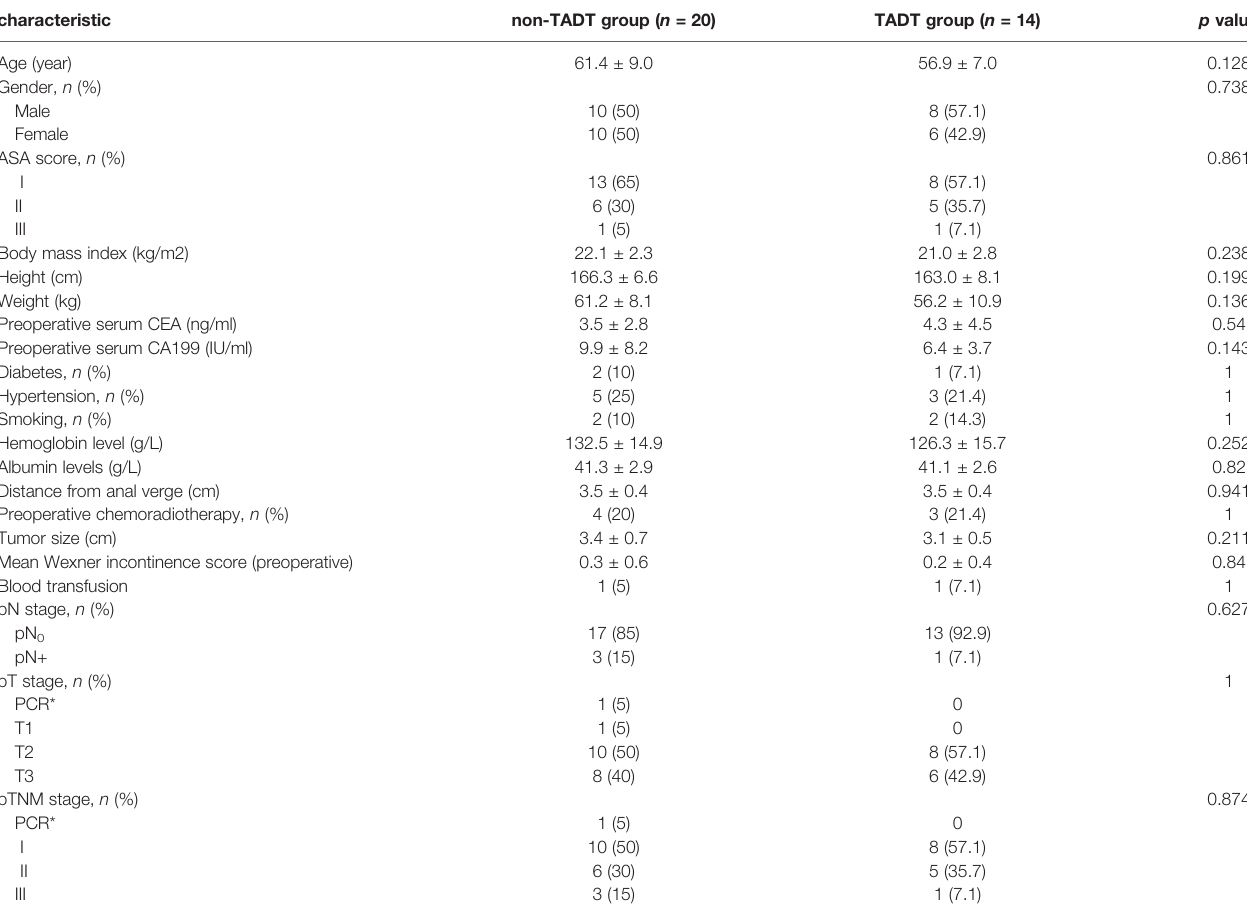
TABLE 1 | Patient characteristics (n = 34).